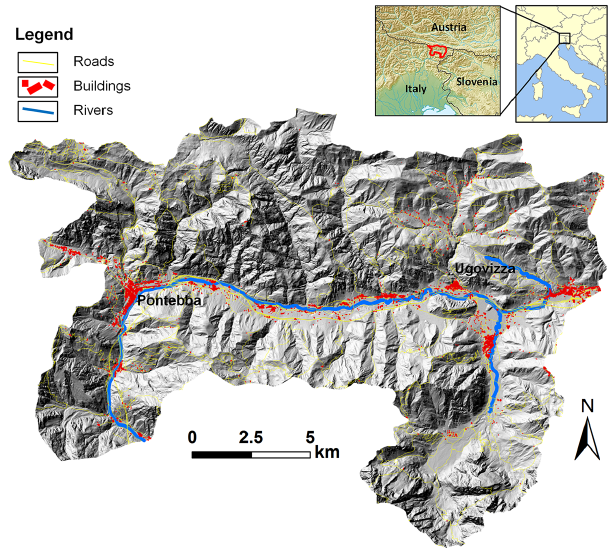
Figure 8. The Fella River study area, Friuli-Venezia Giulia region, northeastern Italy (Data from Chen et al., 2014; Ciurean et al., 2014; Hussin et al., 2014b).